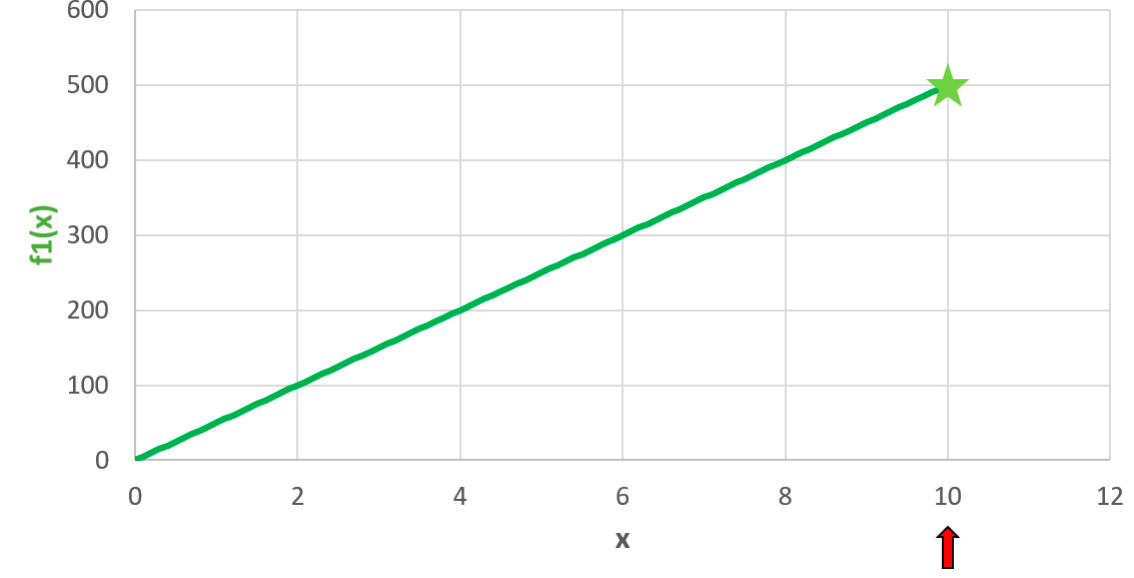
Figure 3. The value of the free GREEN region, to the west of the war front.